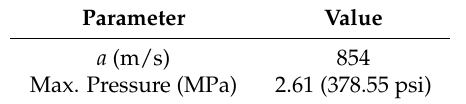
Table 2. Transient flow characteristics